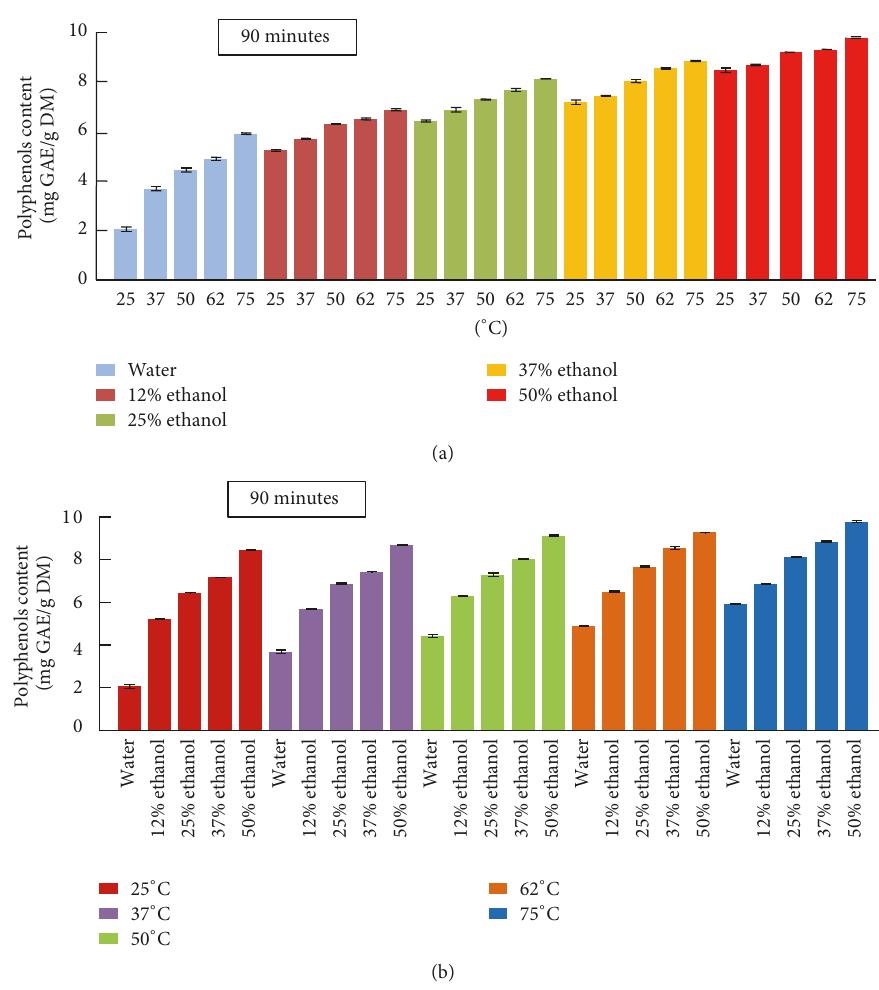
Figure 2: Polyphenol recovery as function of (a) temperature and (b) ethanol percentage at 90 minutes.